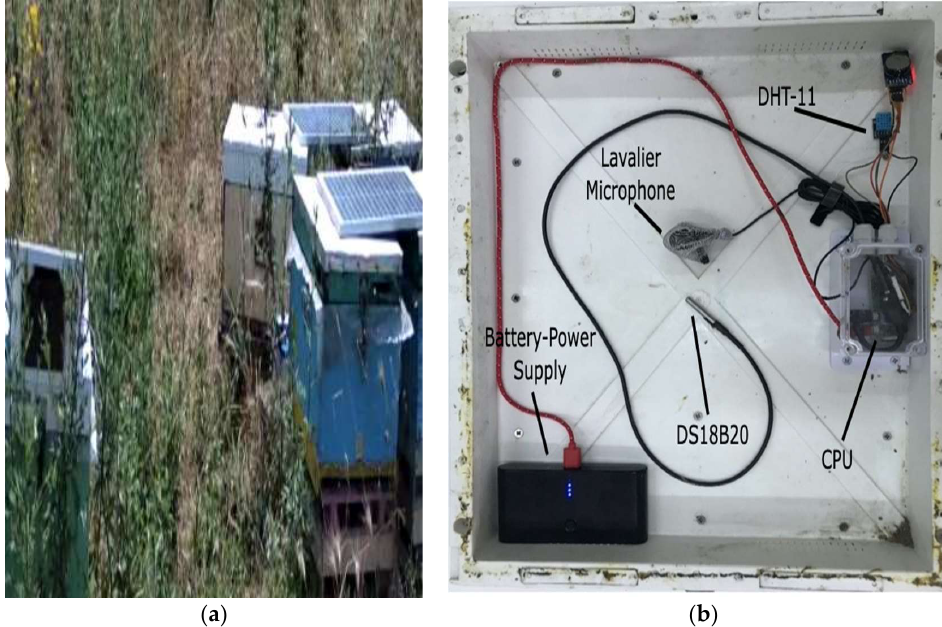
Figure 6. ( a ) BeeSD system proof-of-concept setup and end-node prototype. The right figure shows the prototype experimentation performed in the beekeeping station. ( b ) The BeeSD prototype sensory parts.